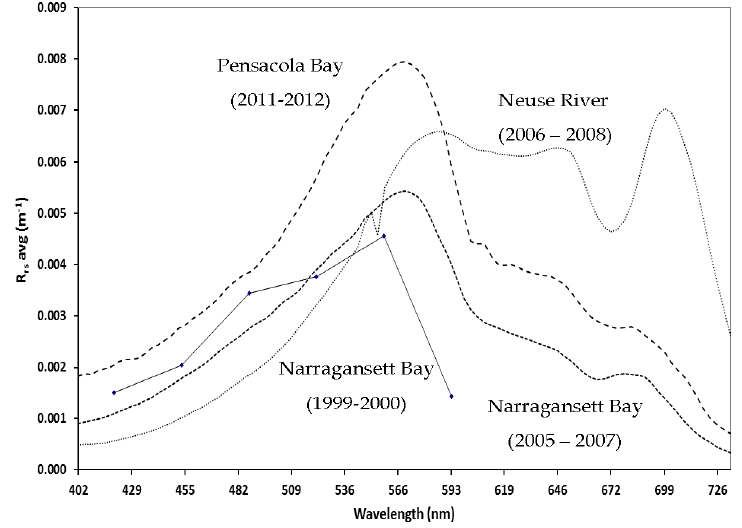
Figure 2. Average remote sensing reflectance spectra for the sampled estuaries and the timeframe of data collection.